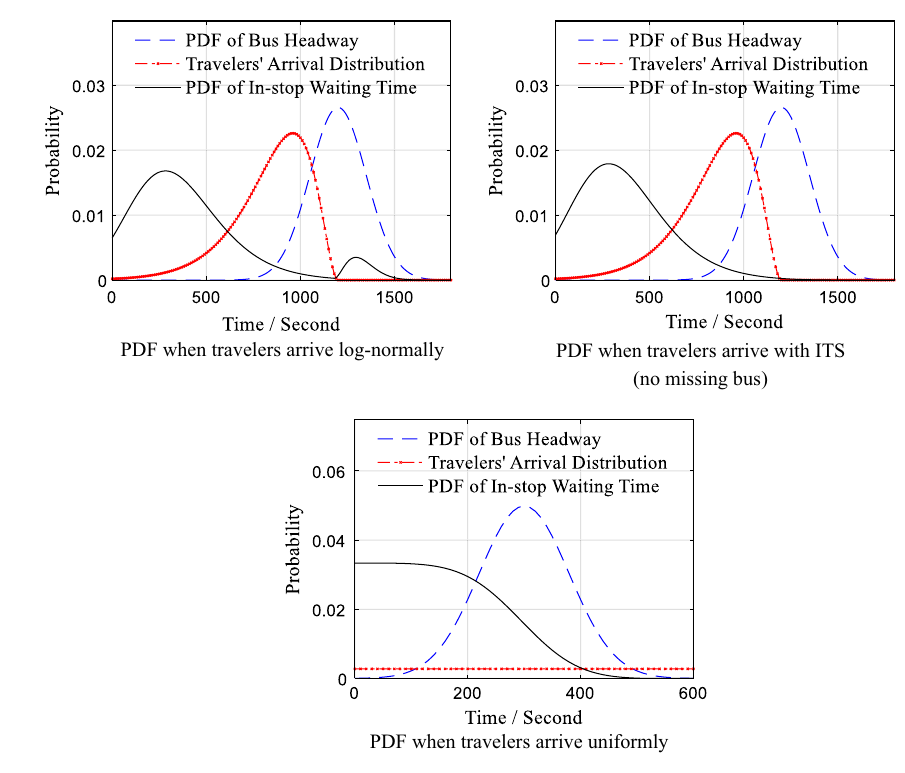
Fig. 10 In-stop waiting time under different travelers’ arrival distribution